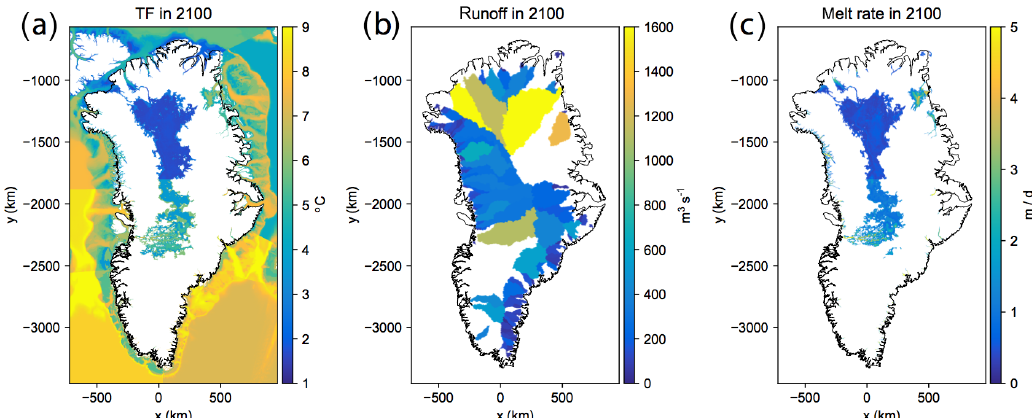
Figure 6. Example of forcing fields in 2100 in the submarine melt implementation, using MIROC5 under an RCP8.5 scenario. (a) Ocean thermal forcing, (b) subglacial runoff and (c) submarine melt rate calculated using the parameterisation in Eq. (2). Note that the thermal forcing and melt rate values in the ice sheet interior are included only to show that the submarine melt implementation defines melt rate everywhere that is below sea level and connected to the ocean. An ice sheet model would only apply these melt rates if the ice sheet margin retreats into the interior, which is unlikely by 2100. Also note that runoff values are only plotted for marine-terminating hydrological